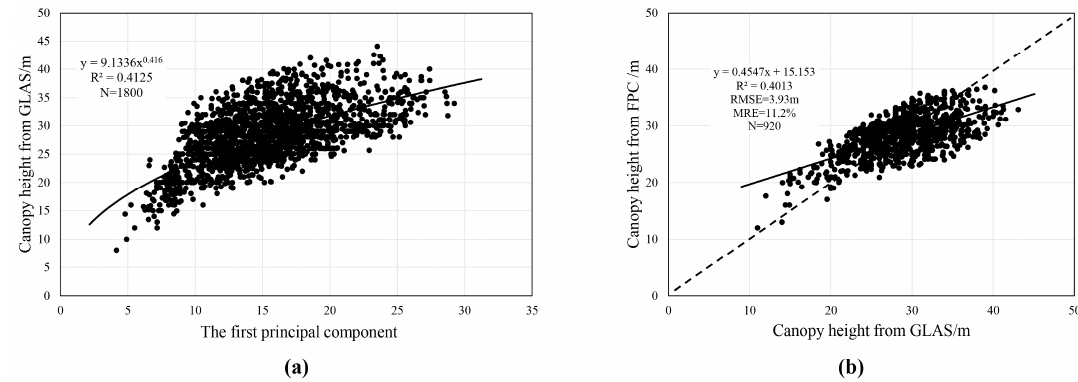
Figure 4. PCA analysis results. ( a ) Power model; and, ( b ) Evaluation of this model.